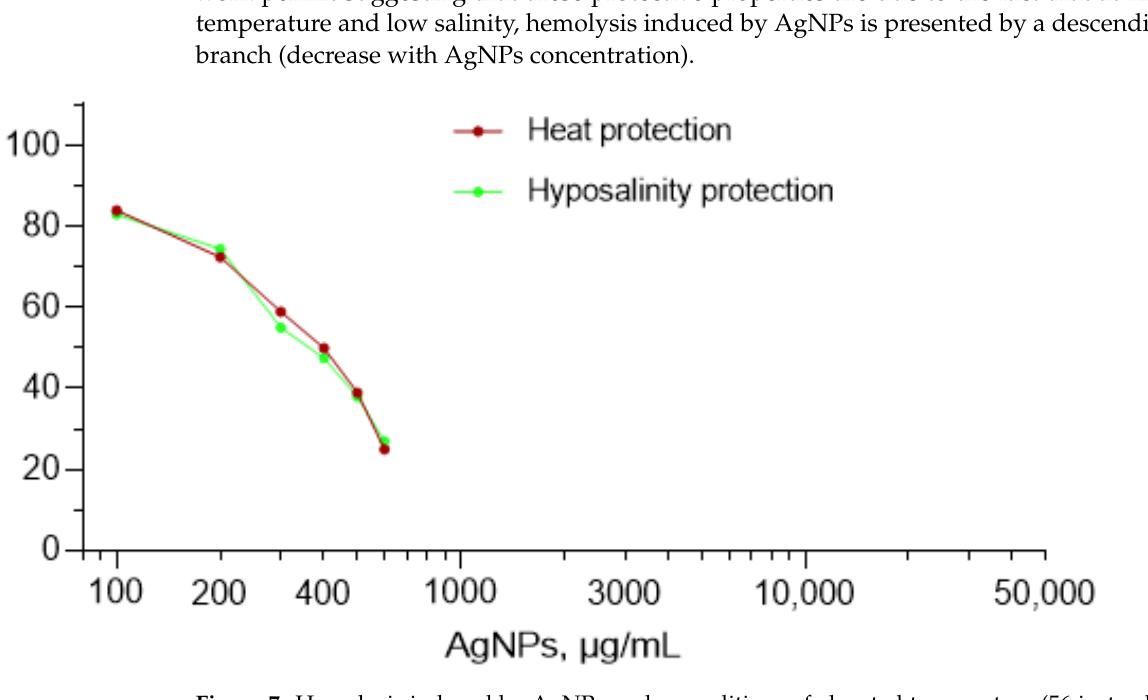
Figure 7. Hemolysis induced by AgNPs under conditions of elevated temperature (56 instead of 37 °C physiological temperature) and hyposalinity (0.1 instead of 1.5 M physiological concentration). The data were Adapted from Ref.